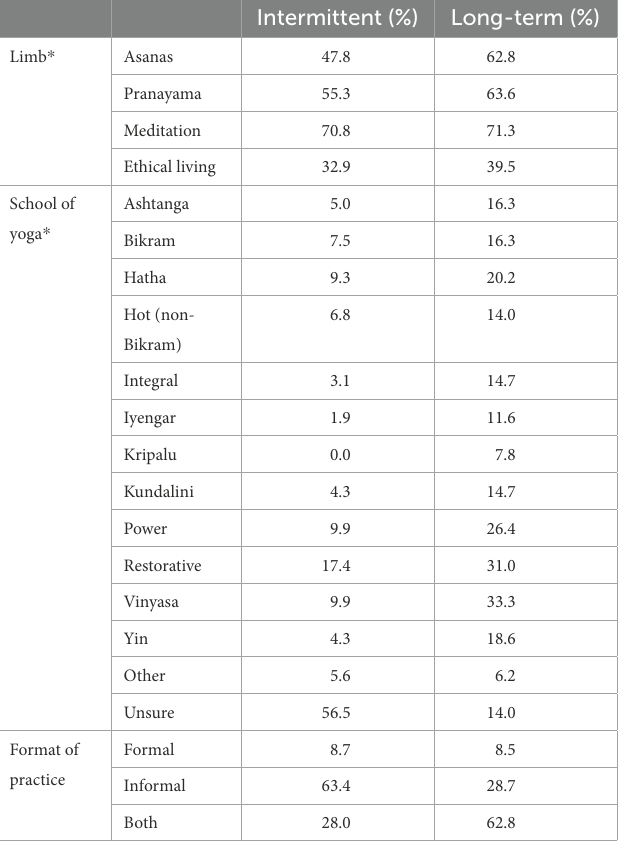
TABLE 3 Participant yoga experience (percentage of participants practicing each limb, school, and format).